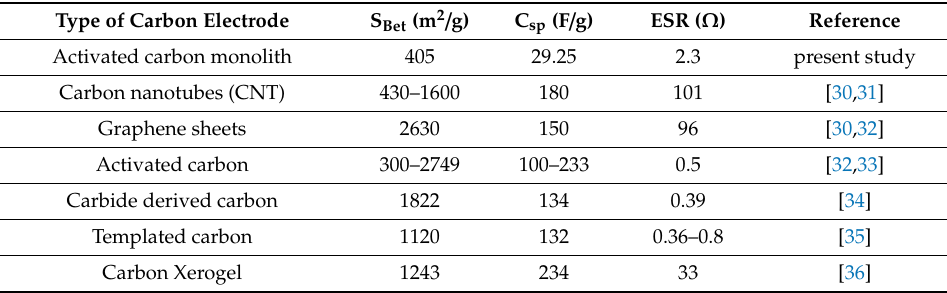
Table 9. S BET , C sp and ESR of various carbon